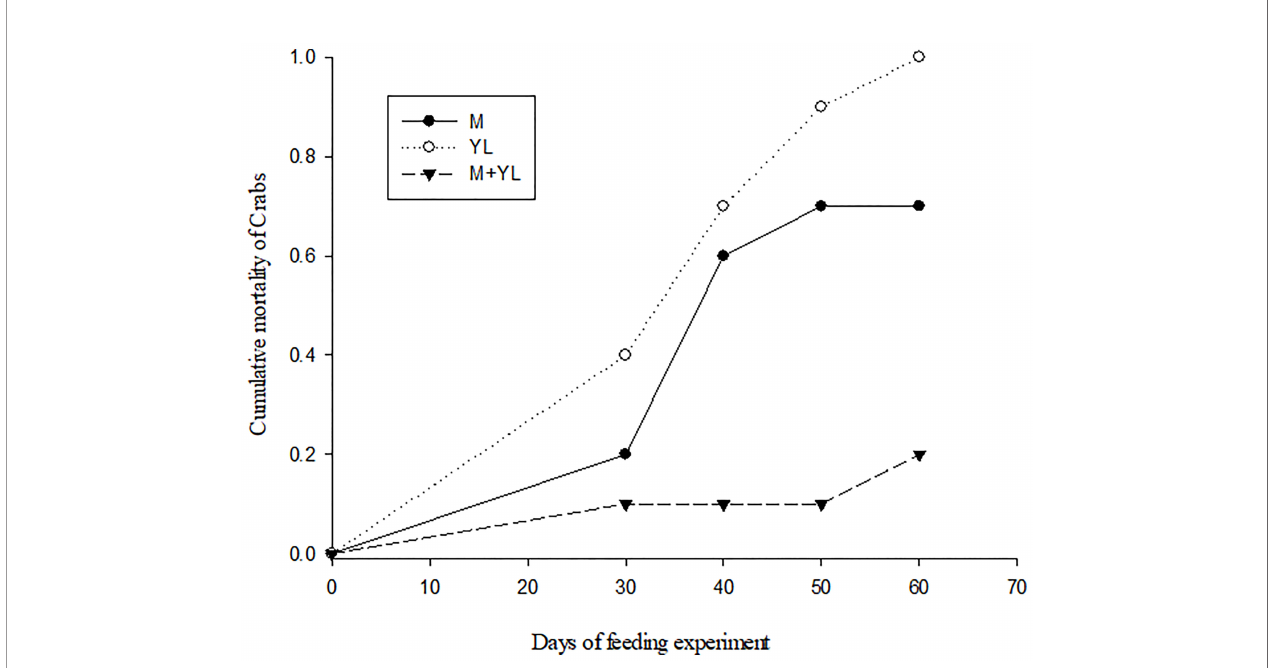
FIGURE 2 | Cumulative mortality (proportion of individuals dead) of P. af fi ne plotted against days offeeding experiment on different food sources. M, Microphytobenthos (MPB) only; L, Yellow leaf of Kandelia obovata only; M+L, MPB and yellow leaf of K. obovata